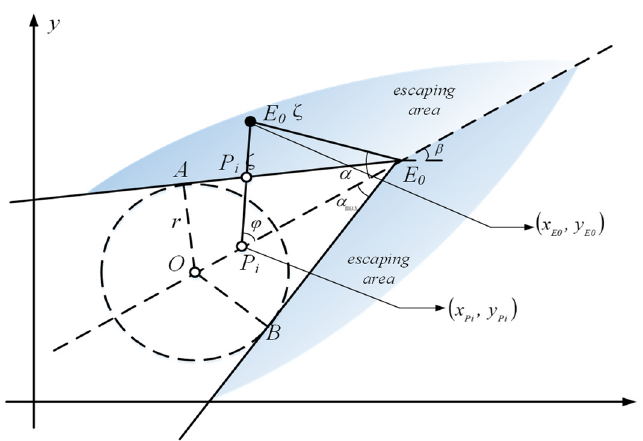
Figure 6. The optimal policy of the pursuer when the escaper escapes.